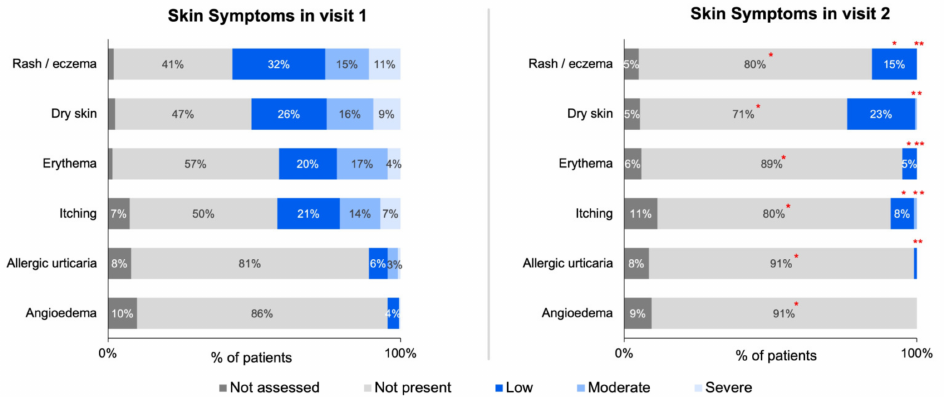
Figure 4. Distribution of skin symptoms severity across initial and follow-up visits for infants ≤ 6 months of age with suspected or diagnosed CMPA. Note: ‘*’ denotes statistically significant symptom improvement between Visit 1 and Visit 2 (specific p -values listed in Figure